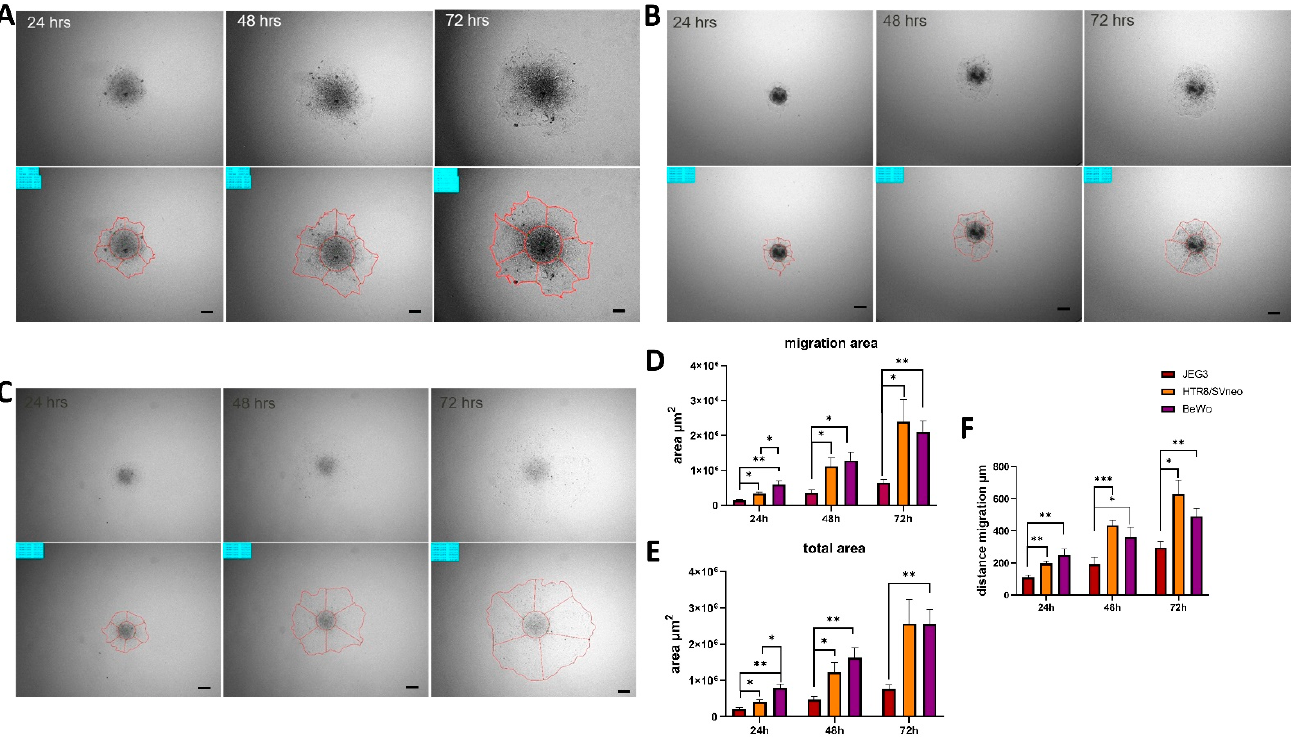
Figure 3. Comparison of migration in trophoblast spheroids. Bright-field images of BeWo ( A ), JEG3 ( B ) and HTR8/SVneo ( C ) at 24, 48 and 72 h and lower panels show the contours that were manually segmented. Comparison of total migratory area ( D ), total spheroid area ( E ) and migratory distances ( F ). Scale bar 100 µm.* p < 0.05; ** p < 0.01; *** p < 0.001.